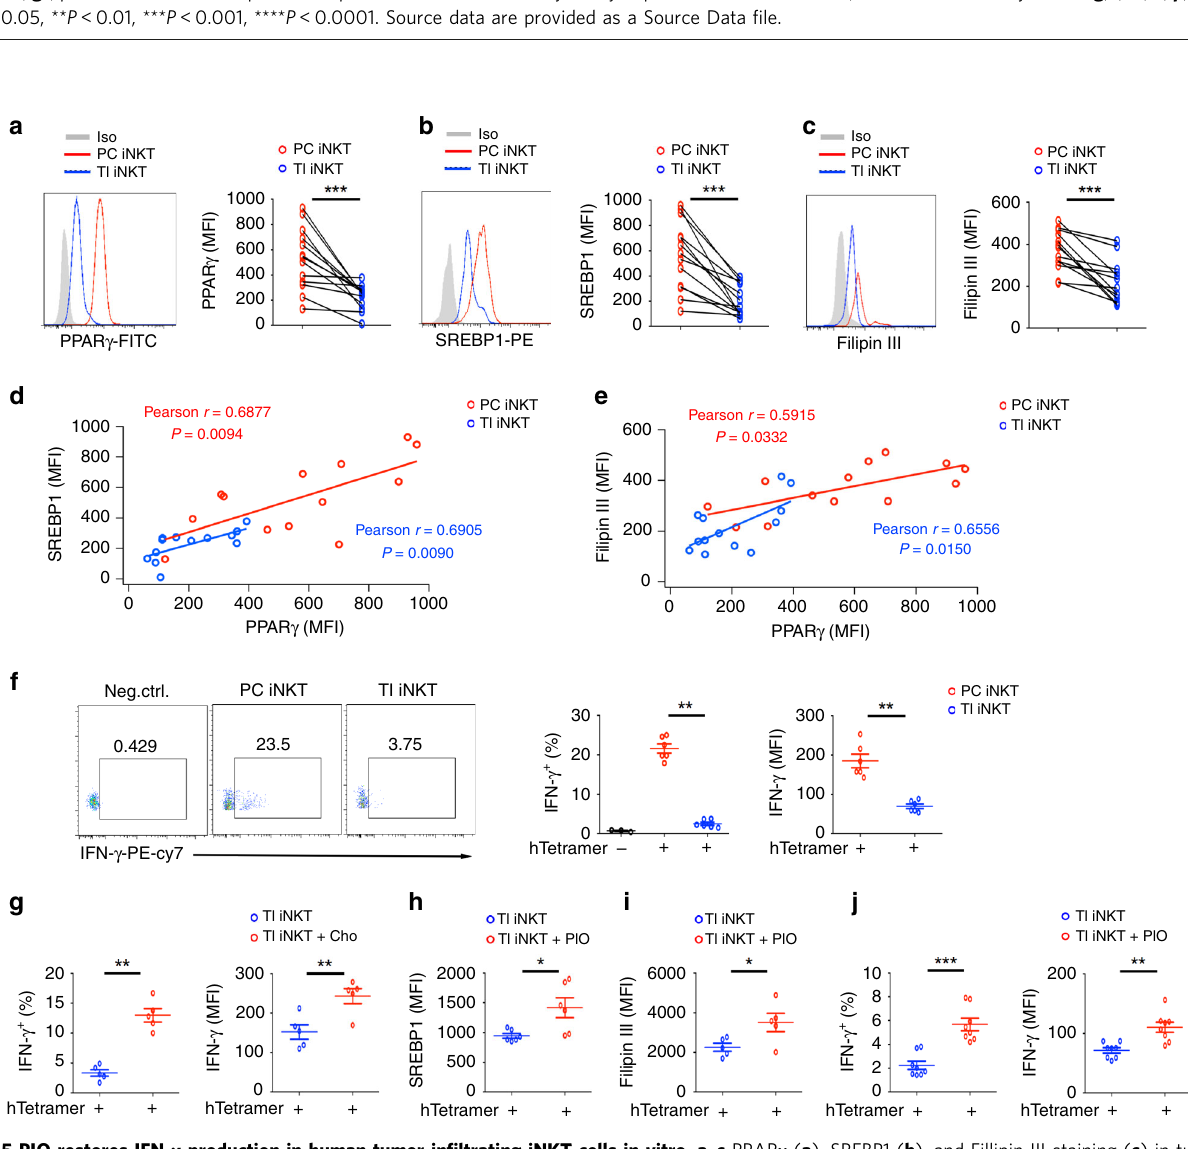
Fig. 4 PPAR γ directly promotes transcription of Srebf1 in cooperation with PLZF. a In fl uences of T007 on mature and immature forms of SREBP1 and SREBP2 in expanded iNKT cells after activating overnight. b Total SREBP1 protein in iNKT cells measured by fl ow cytometry. c – e Effects of Pparg shRNA or Srebf1 shRNA on SREBP1 expression ( c ), Fillipin III staining ( d ), and percentages of IFN- γ + iNKT cells after activation ( e ). f , g SREBP1 expression ( f ) and Fillipin III staining ( g ) in iNKT from PLZF-cre Pparg fl / fl mice and Pparg fl / fl mice. h , i Fragments in Srebf1 promoter region ( h ) and binding of these fragments to PPAR γ measured by ChIP-qPCR ( i ). j Co-immunoprecipitation of PPAR γ and PLZF in expanded iNKT cells with indicated treatments. ( k , l ) Co- localization ( k ) and co-localization coef fi cient ( l ) of PPAR γ and PLZF in iNKT cells with indicated treatments. Bar, 5 μ m. m mRNA of Pparg1 and Pparg2 in iNKT, CD4 + T, and CD8 + T cells. n Expression of PPAR γ , PLZF, and SREBP1 in 293 T cells overexpressing PPAR γ 1, PPAR γ 2, PLZF, PPAR γ vector ( γ .V.), and